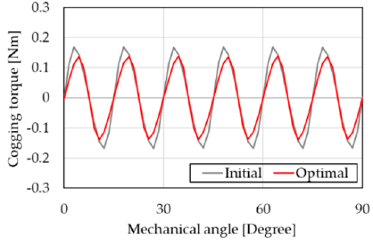
Figure 11. Comparison of the cogging torque characteristics.